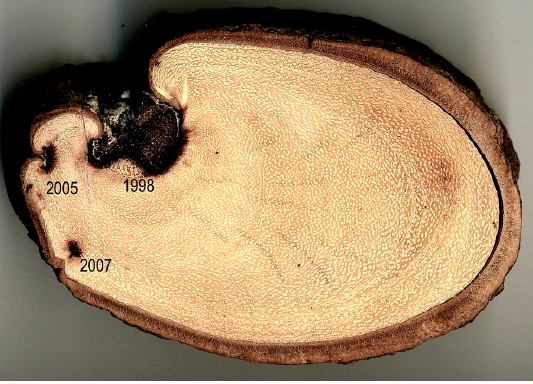
Figure 8. Tamarind root section from the Ankoba riverbank. The section shows changes in structure from root to stem-type cells after the damage that occurred in the 1998 flood (Figure 9) when the root was first exposed to the air and subsequently during the floods of 2005 and 2007).